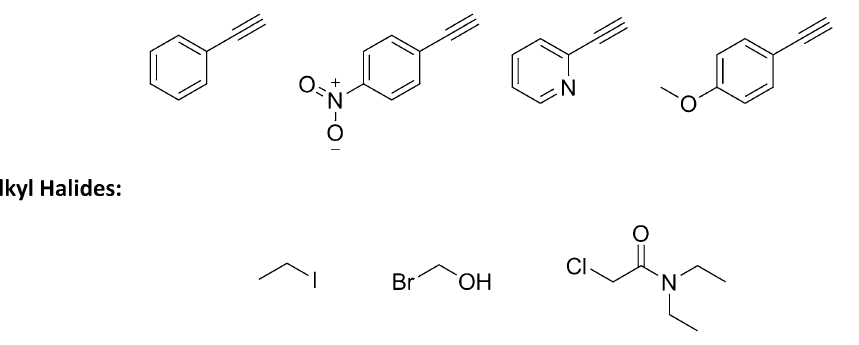
Figure 2. Acetylene and Alkyl Halides derivatives used in library